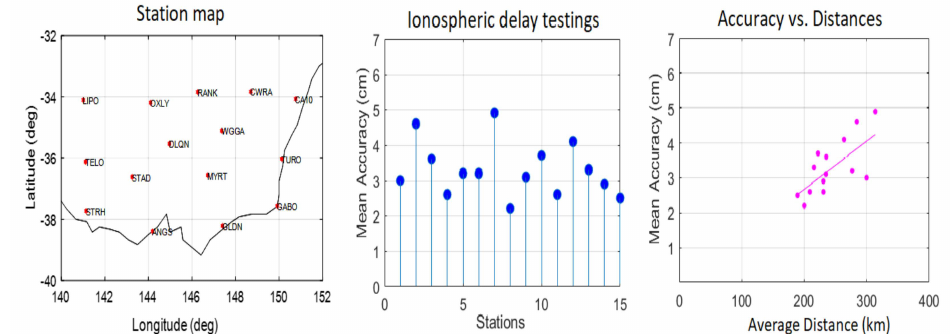
Figure 5. ( Left ) Maps of 15 CORS stations including names of ten stations in VIC and five stations (CWRA, RANK, WGGA, DLQN and OXLY) from the neighbouring NSW. The red asterisks present coordinates of those stations. ( Middle ) The average accuracy of the interpolated ionospheric correc- tions for each station on 6 May 2021. ( Right ) The accuracy as a function of the average separation distance of the testing station to the three nearest stations in the network, same as Figure 4.